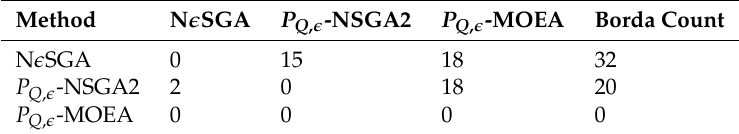
Table 8. Summary of times a method outperforms another with statistical significance. Method N (cid:101) SGA P Q , (cid:101) -NSGA2 Borda